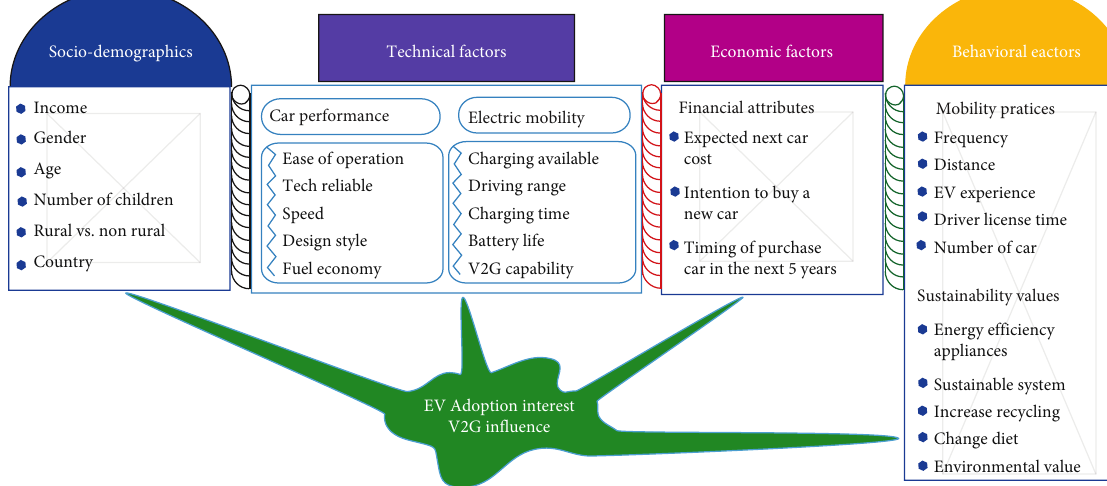
Figure 14: Conceptual framework for EV adoption and the in fl uence of V2G [149].